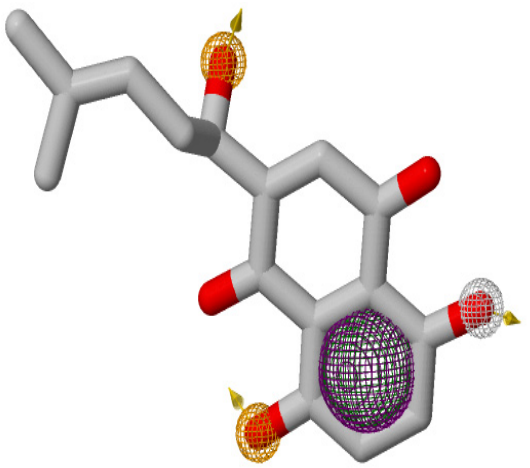
Figure 3. Pharmacophore features generated for Shikonin on ZINCPharmer. The hydrophobic, hydro- gen bond donor, and hydrogen bond acceptors, and aromatic features are displayed in mesh spheres of green, white, orange, and purple, respectively. The orange arrows indicate the constraint direction.